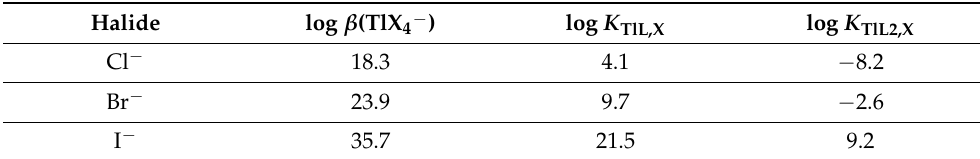
At pH = const ., the previous relationships are valid for conditional equilibrium constants. Table A1. The equilibrium constants of exchange reactions of the system Tl(III)-PANS-halide (log β (TlL) = 14.18, log β (TlL 2 ) = 26.52 [53,59]).